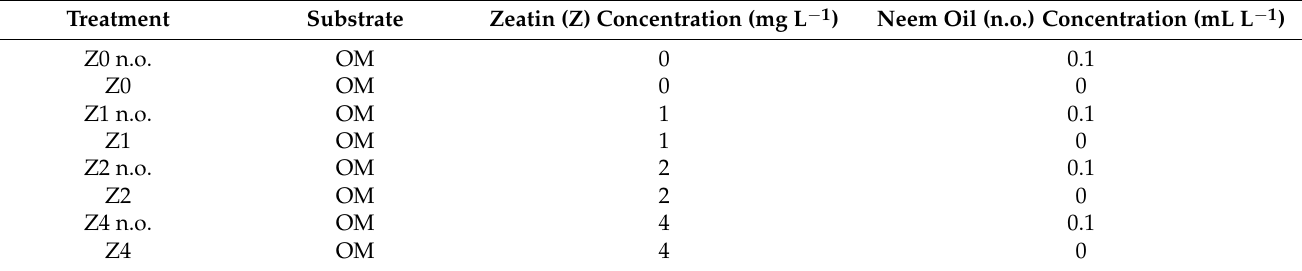
Table 4. Substrates used for the proliferation phase and their characteristics in terms of zeatin (Z) concentration and neem oil (n.o.)